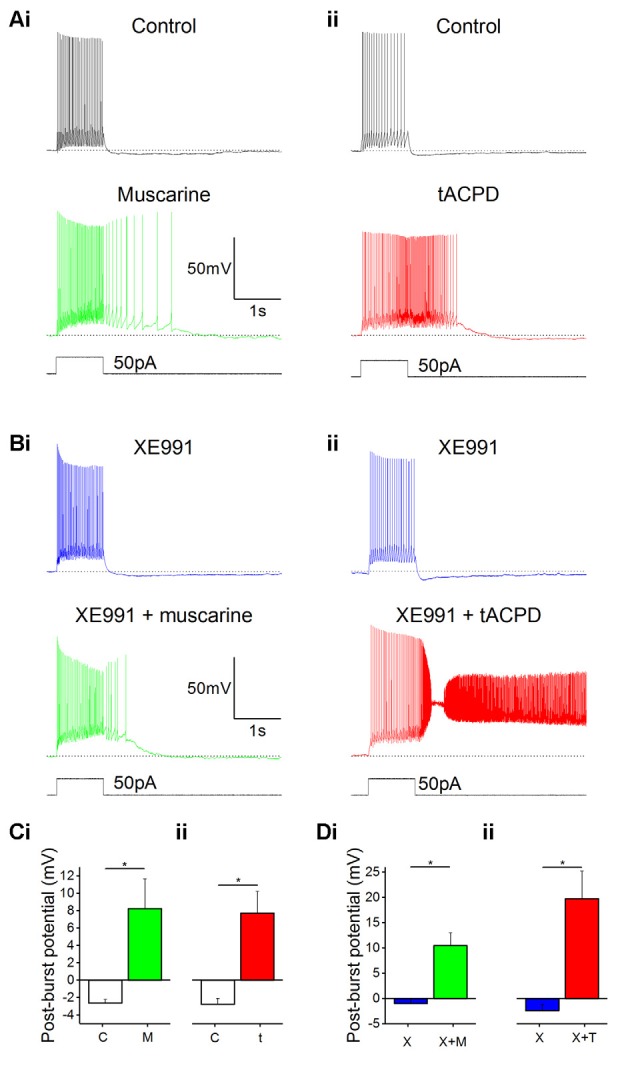
mAChR and mGluR activation induce plateau potentials in oriens-lacunosum moleculare (OLM) cells. (A) Example traces showing the onset of a plateau potential following the application of either muscarine (Ai) or t-ACPD (Aii). (B) Example traces showing that blocking M-current with XE991 did not induce post-pulse spiking or plateau potentials, but these effects could be induced with additional application of muscarine (Bi) or tACPD (Bii). The horizontal, dotted lines in (A,B) indicate the baseline membrane potential during a 200 ms time window prior to the current pulse onset. (C) Summary plots showing the change in post-burst potential from control with either application of either muscarine (Ci; n = 6) or tACPD (Cii; n = 7), moving from an afterhyperpolarization (AHP) to an after-depolarization (ADP) in both conditions. (D) Summary plots showing the change in post-burst potential in the presence of XE 991 and following the application of either muscarine (Di; n = 6) or t-ACPD (Dii; n = 6). Both agonists induced a significant change in the post-pulse potential following in the presence of XE 991. Error bars = SEM. *P < 0.05.